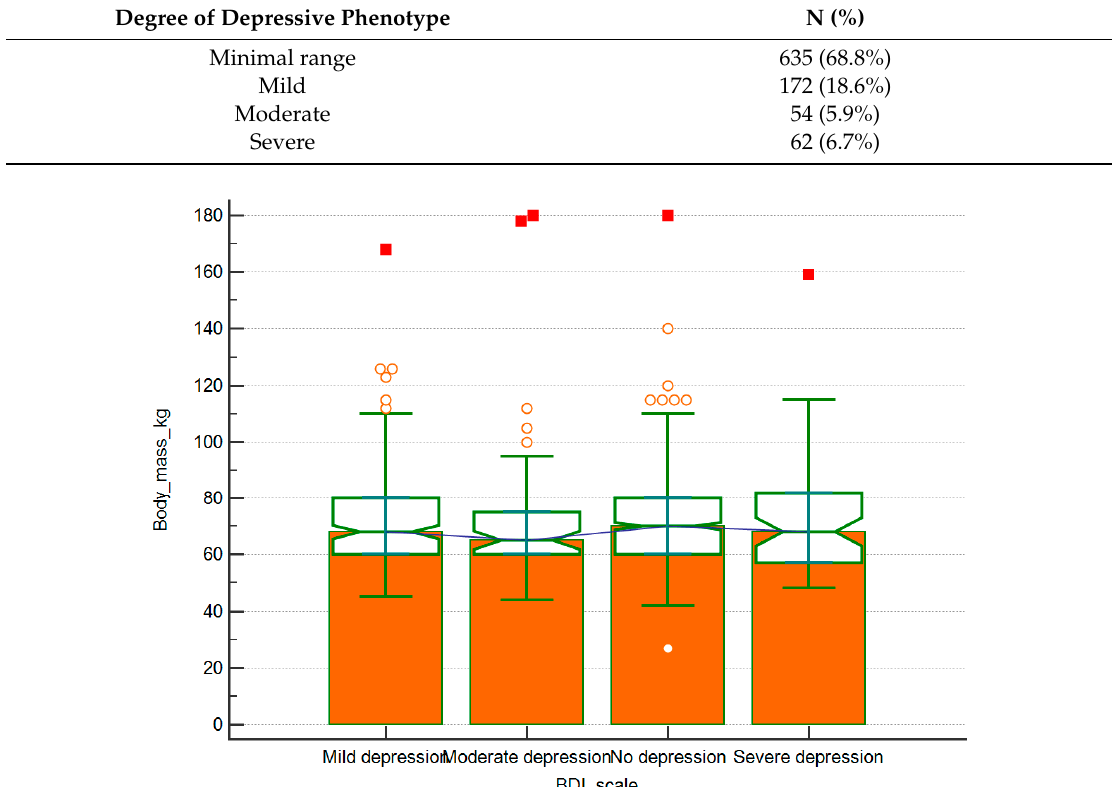
Figure 1. Bodyweight distribution in respondents with various degrees of depressive symptoms according to the BDI-II questionnaire.